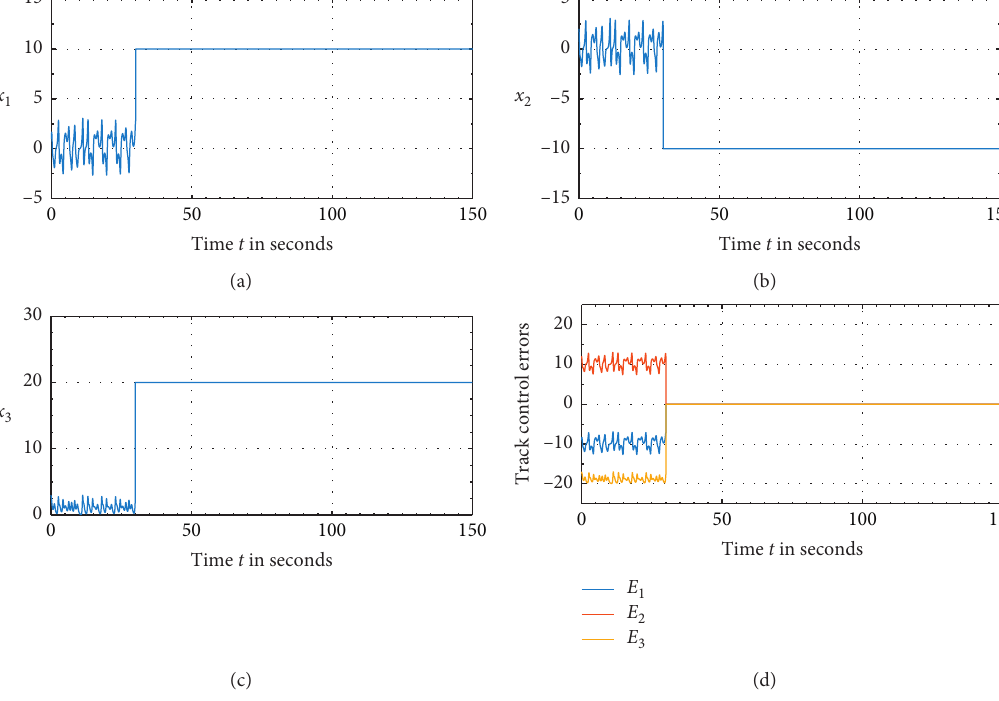
; (c) the state variable x 2